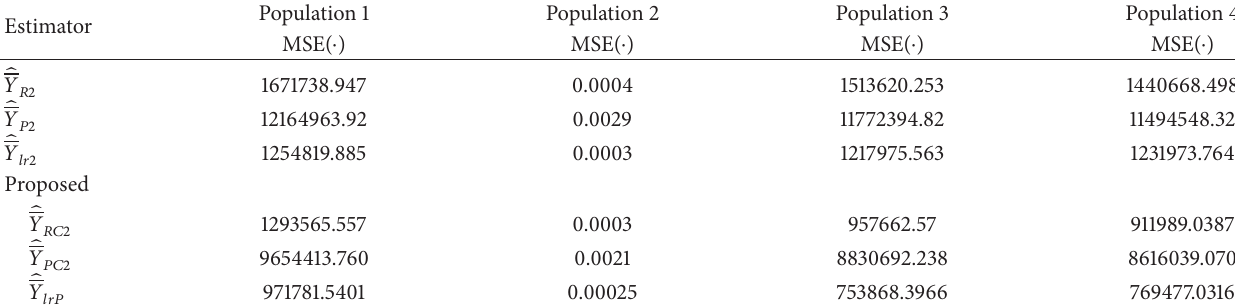
Table 1: MSE of the existing and the proposed